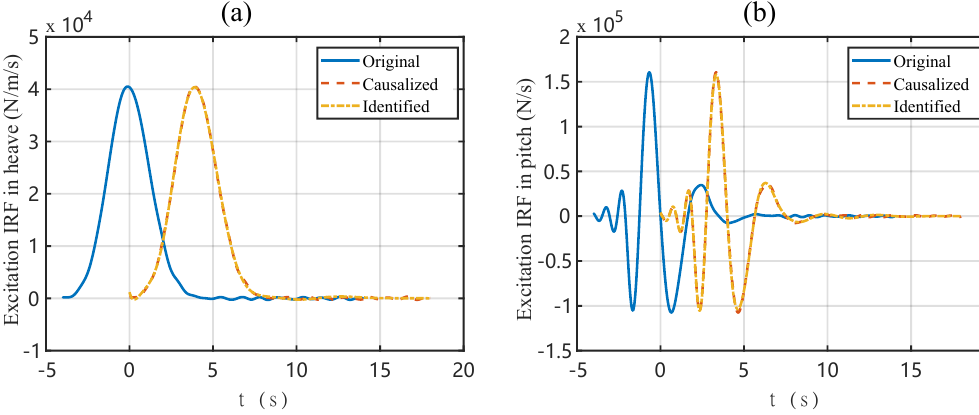
Fig. 4. Excitation approximation in (a) heave and (b) pitch motions, respectively.